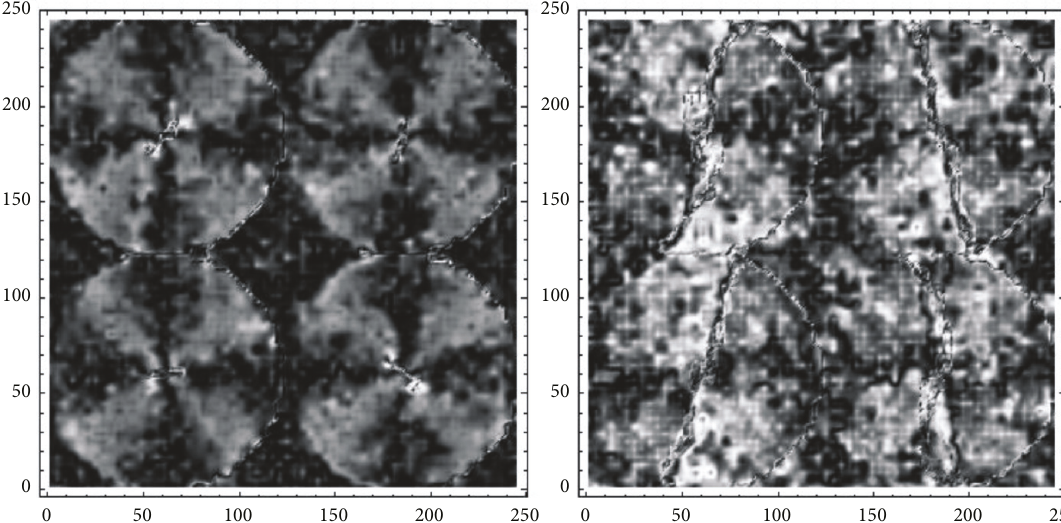
Figure 3: Polarizing optical microscopy patterns for two thicknesses: L = 10 (left) and L = 30 (right). These patterns correspond to spin configurationsillustrated in Figures1 and 2. Thelaser wavelength445 nm was arbitrary chosen,and the ordinary and extraordinary refraction indices 1.544 and 1.821 correspond to NLC E7 [12, 13]. The real thickness was set to h = 2 𝜇 m for the L = 10 cell and 6 𝜇 m for the L = 30 cell.